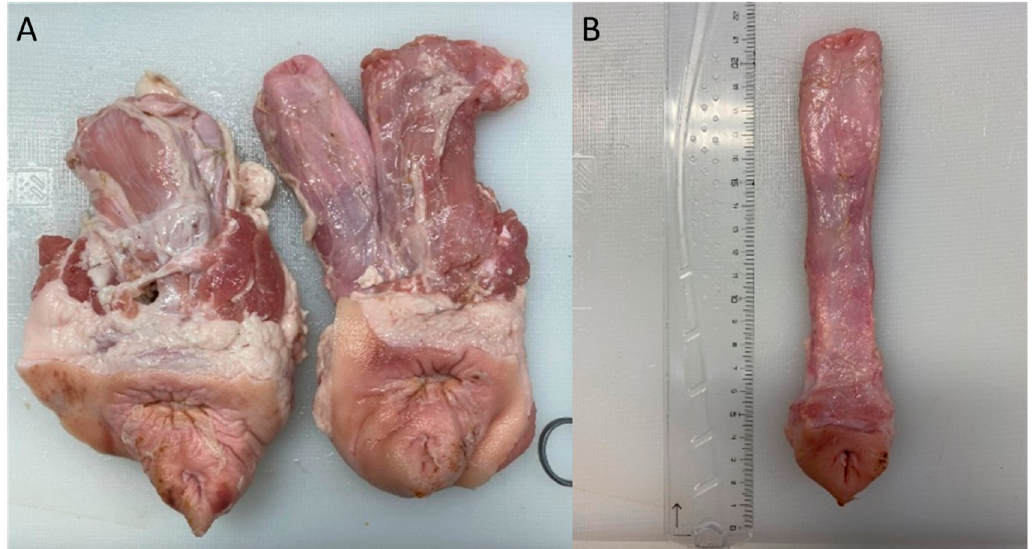
Figure 2. ( A )—pelvic floor soft tissues collected from the slaughterhouse; ( B )—separated vaginal canal.